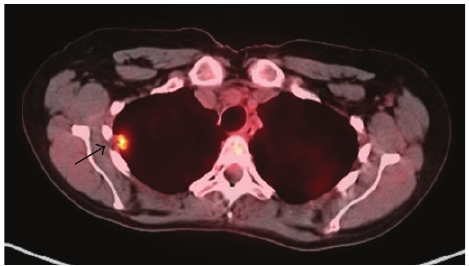
Figure 2: PET scan showing increased uptake in RUL nodule (arrow).